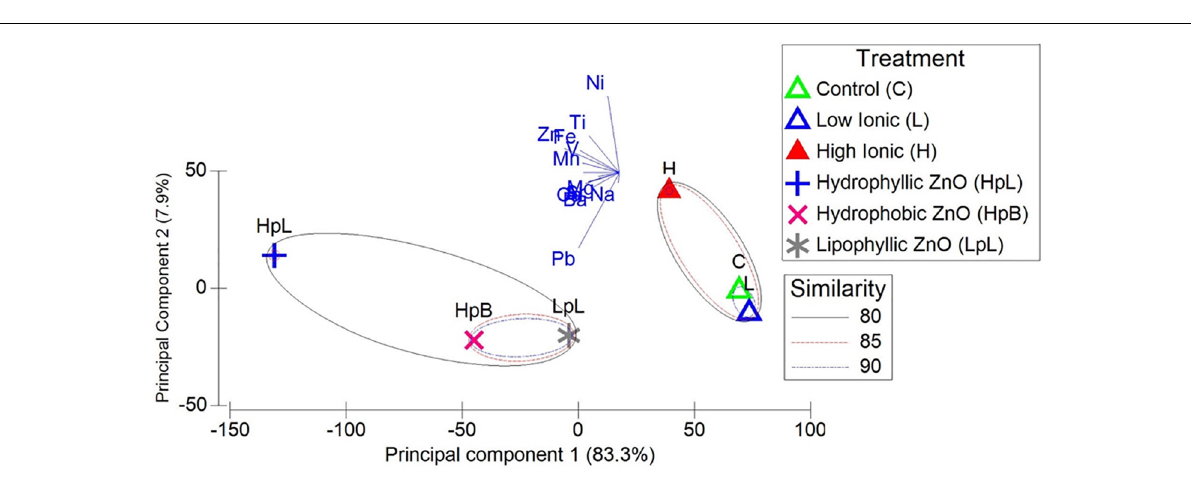
FIGURE 2 | PCA of ICP-MS analysis of the concentration of metals in biofilms cultivated with South Saskatchewan River water and exposed to ionic and ZnO-NP treatments. Length of variable loadings are scaled according to R 2 value, thus the length of each vector represents the strength of correlation or magnitude of change in the direction of each line. Prediction ellipses with probability of 0.80, 0.85, and 0.90 are presented. N = 30 data